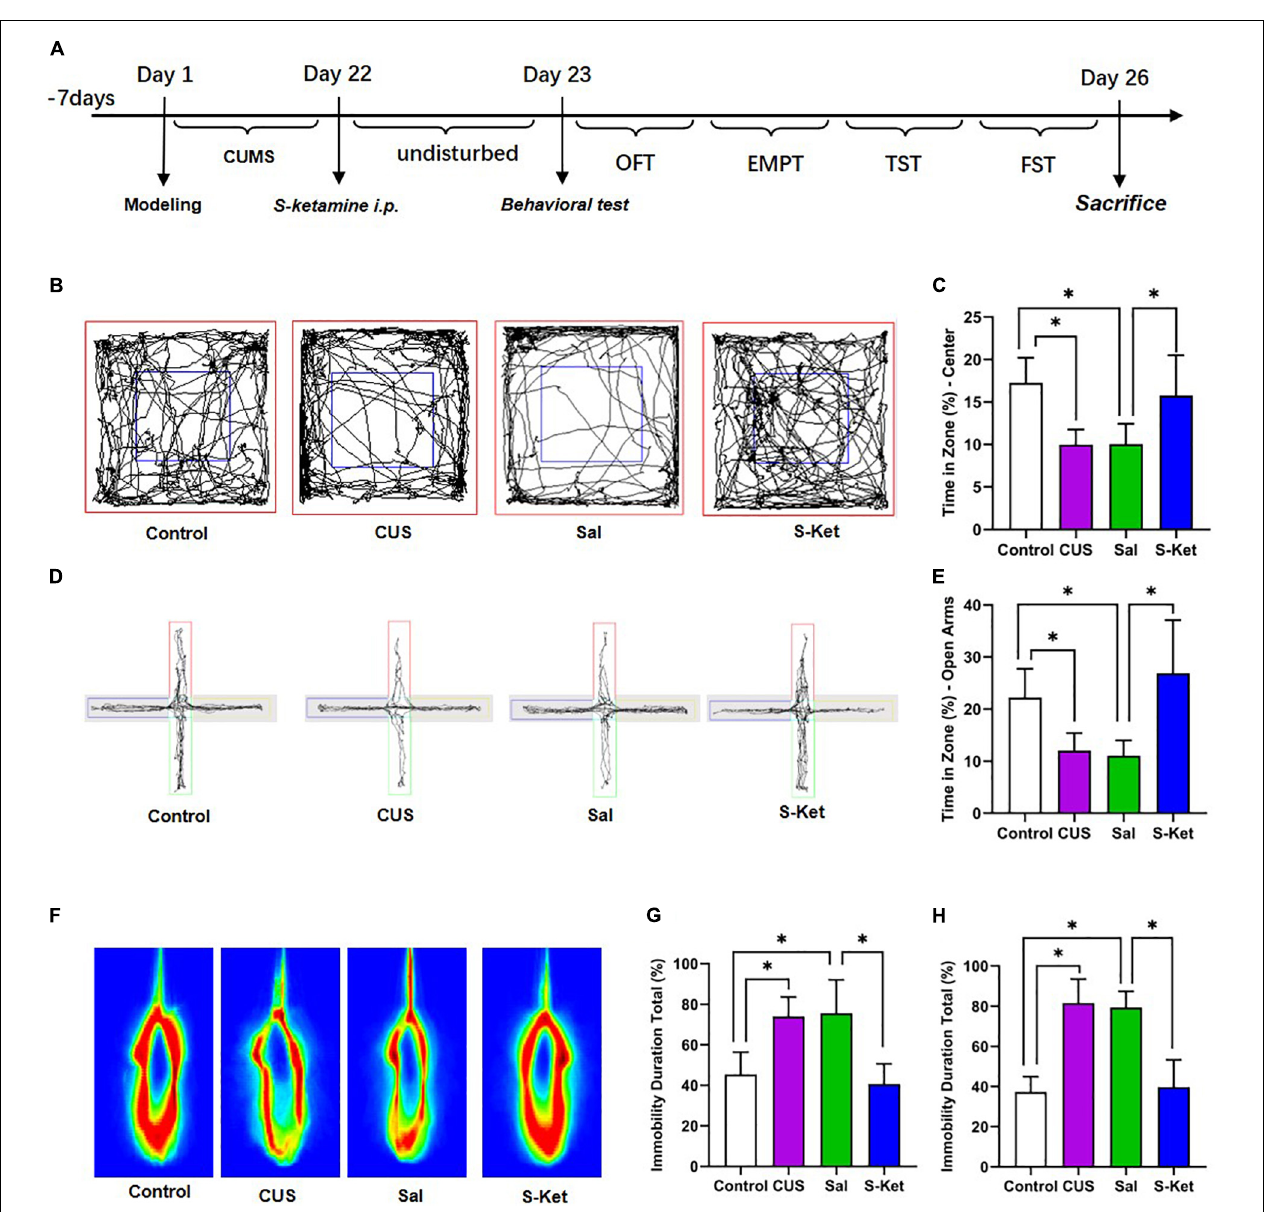
FIGURE 1 | S-ketamine relieved depression-like behaviors of mice exposed to CUS. (A) Procedure of the experiment 1. (B,C) Motion trail and time of the center zone in OFT ( n = 5–8). (D,E) Motion trail and time of the open arms in EPM ( n = 5–7). (F,G) Percentage of immobile time in the TST ( n = 7–8). (H) Percentage of immobile time in the FST ( n = 7–9). The data are expressed as the mean ± standard error, and ∗ P <